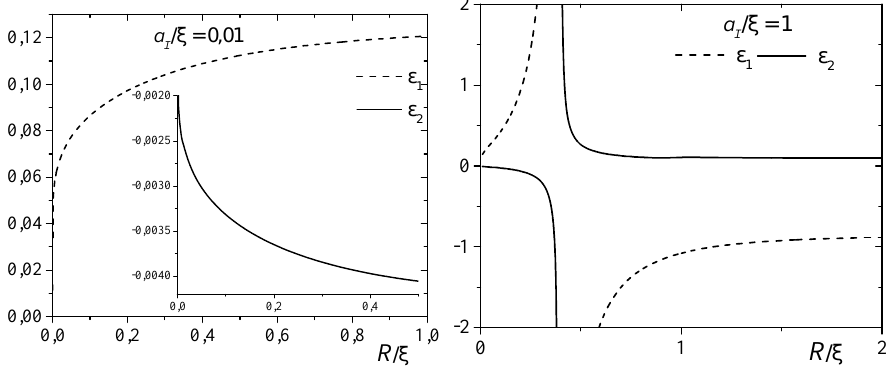
(cid:16) (cid:17) a I in 2D dilute ; R ξ ξ